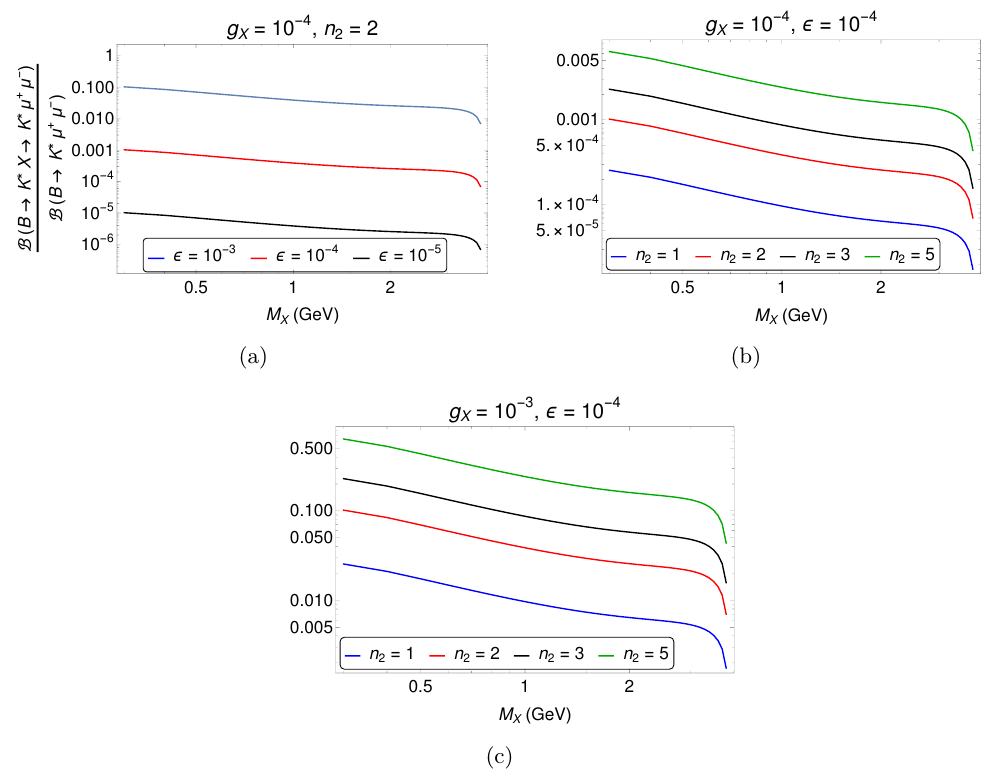
Figure 2 . Variation of B ( B 0 → K ∗ 0 χ ( µ + µ − )) / B ( B 0 → K ∗ 0 µ + µ − ) as a function of the mass M X for different values of (a) the mixing parameter ‘ (cid:15) ’ and (b) the U (1) X charge n i . From figures (b) and (c), we can check the dependence of the above ratio on the coupling g X